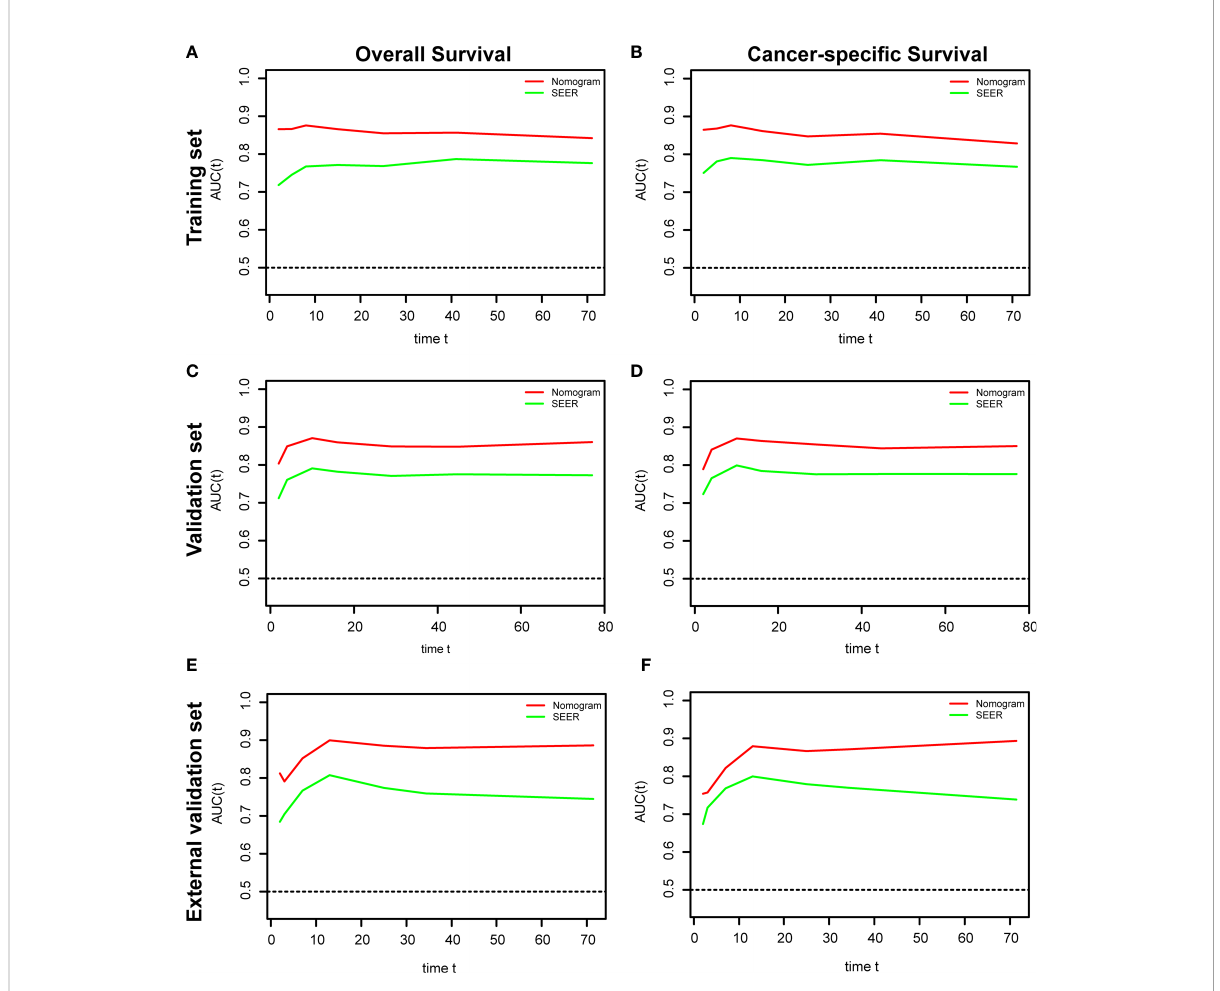
FIGURE 4 Time-dependent receiver operating characteristic (ROC) analysis based on nomograms and SEER stage. (A) The time dependent ROC analysis of OS in the training set. (B) The time-dependent ROC analysis of CSS in the training set. (C) The time-dependent ROC analysis of OS in the validation set. (D) The time-dependent ROC analysis of CSS in the validation set. (E) The time-dependent ROC analysis of OS in the external validation set. (F) The time-dependent ROC analysis of CSS in the external validation